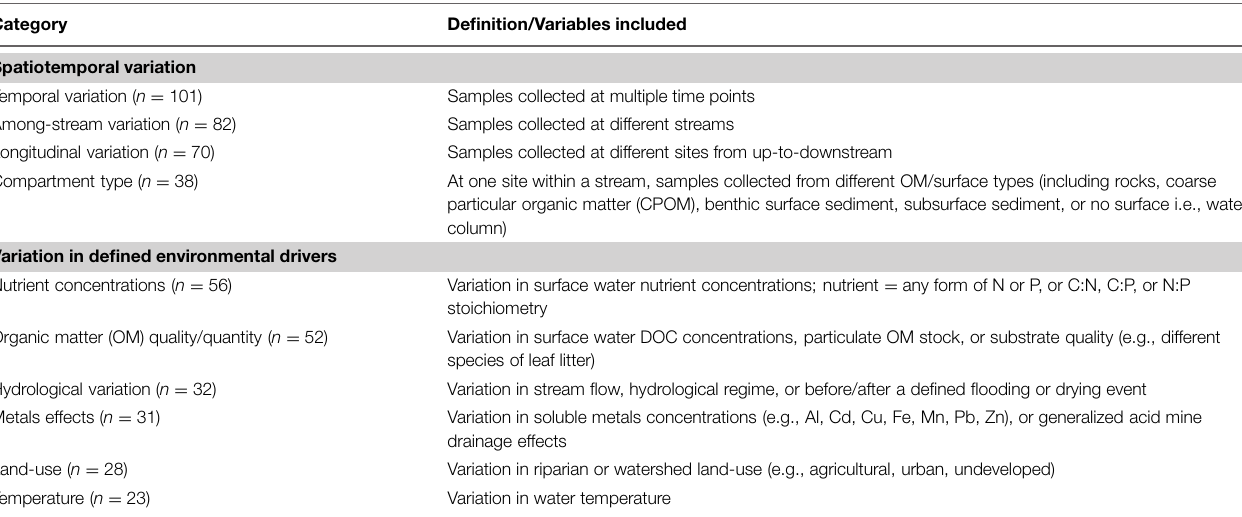
TABLE 1 | Categories of environmental variation evaluated for effects on stream microbial